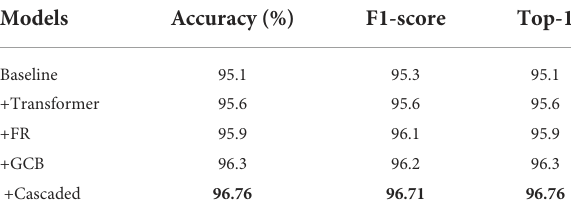
TABLE 3 Comparison of the effectiveness of each module of CBNet (bold represents the model with the best results). Models